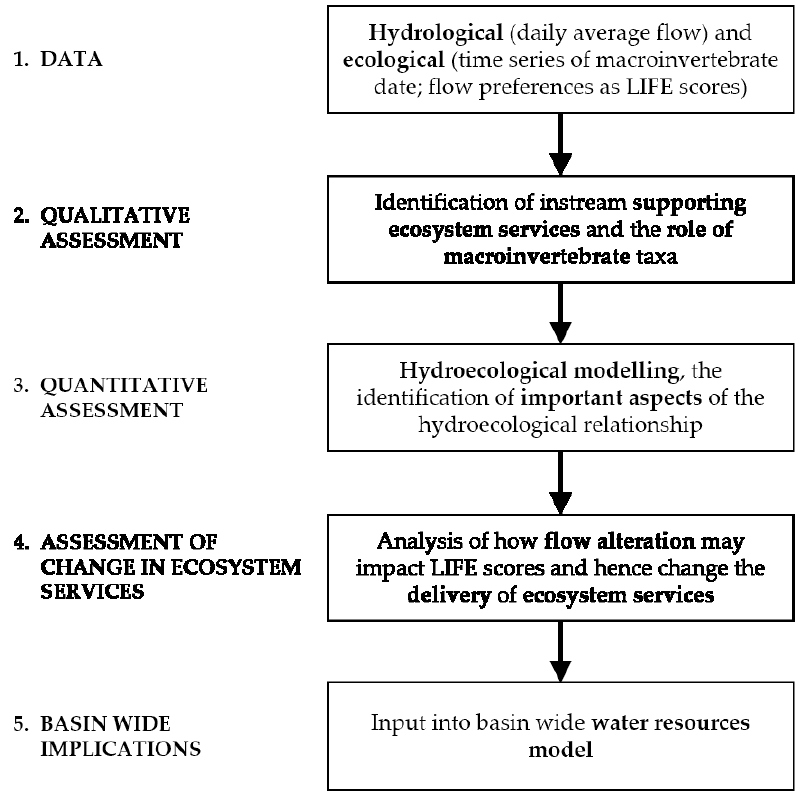
Figure 1. Outline of the proposed framework.